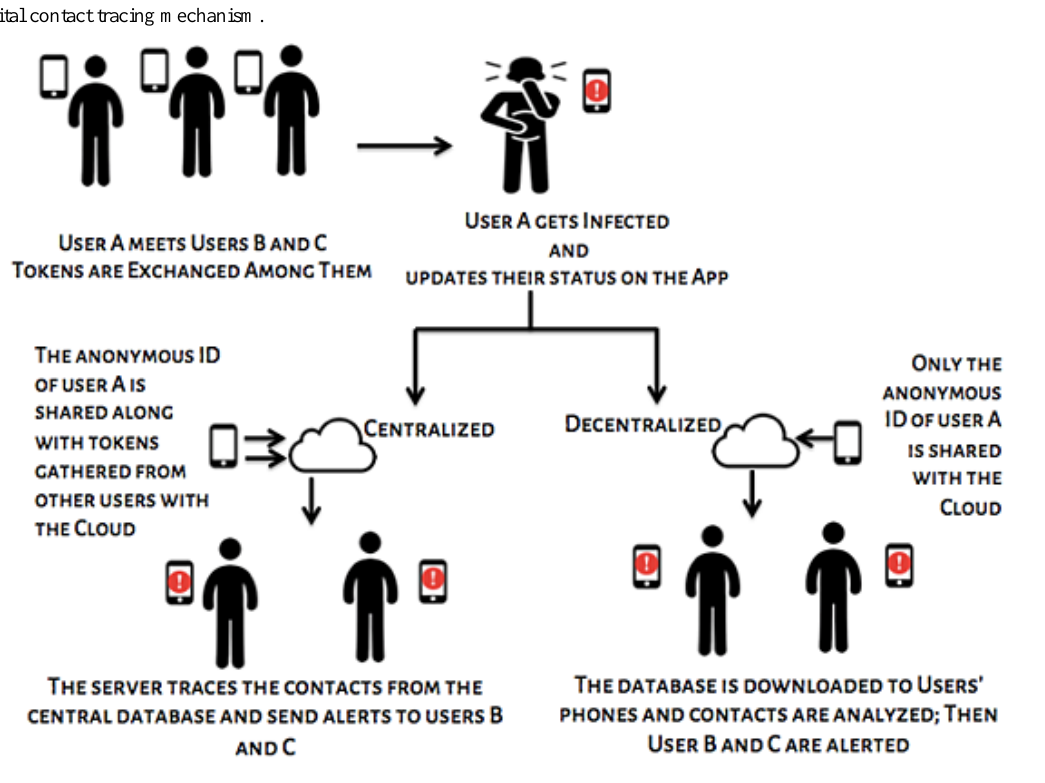
Figure 1. Digital contact tracing